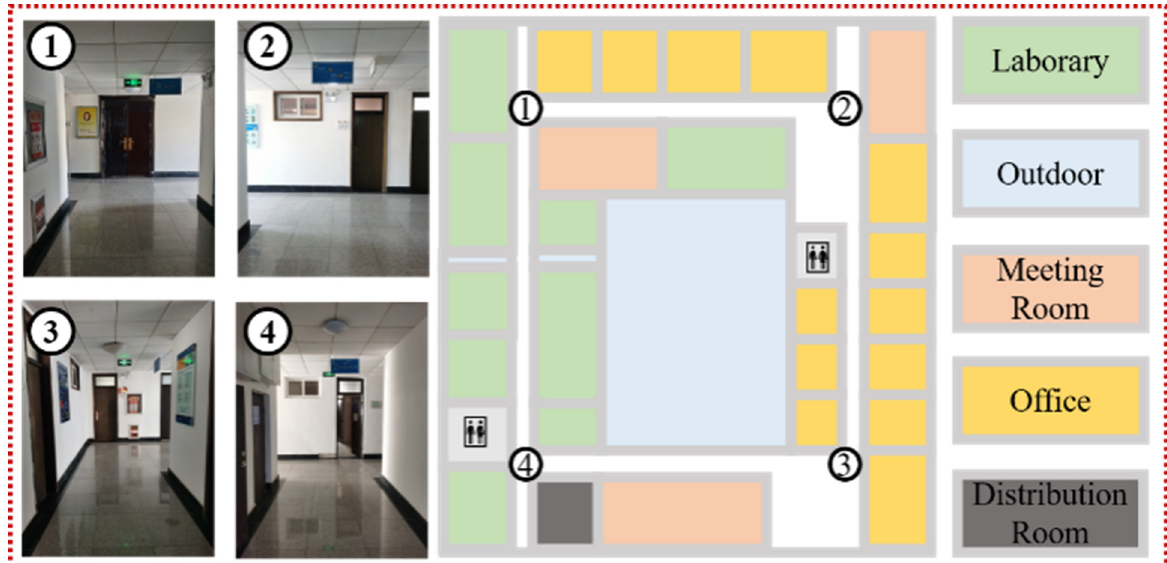
Figure 6. Schematic diagram of the office building scene.